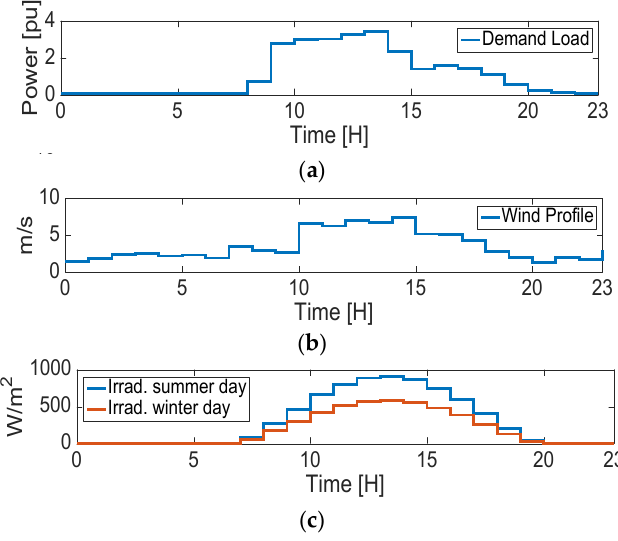
Figure 8. Forecasting curves for the microgrid test. ( a ) Load forecast curve; ( b ) wind speed profile for Almería, Spain; ( c ) irradiation profile for clear days in summer (blue) and winter (red).